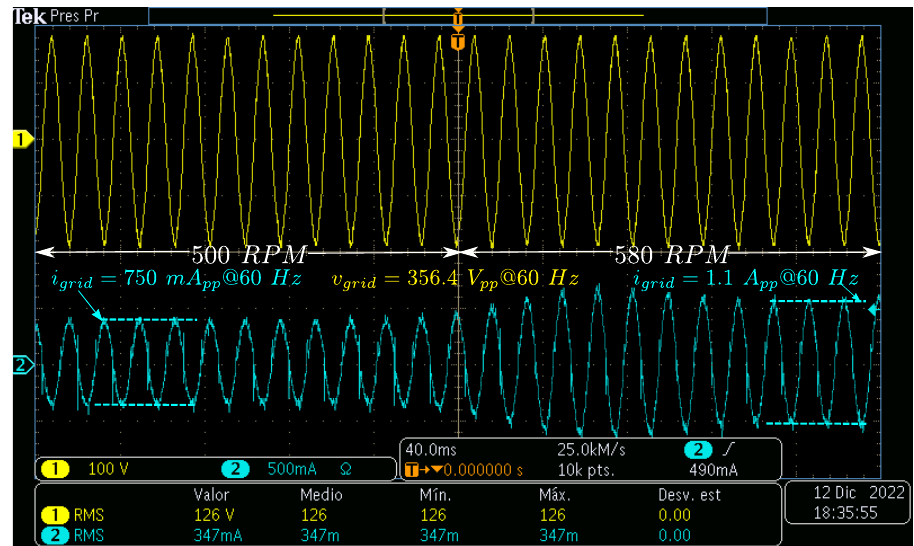
Figure 13. AC voltage and current waveforms for speed change from 500 to 580